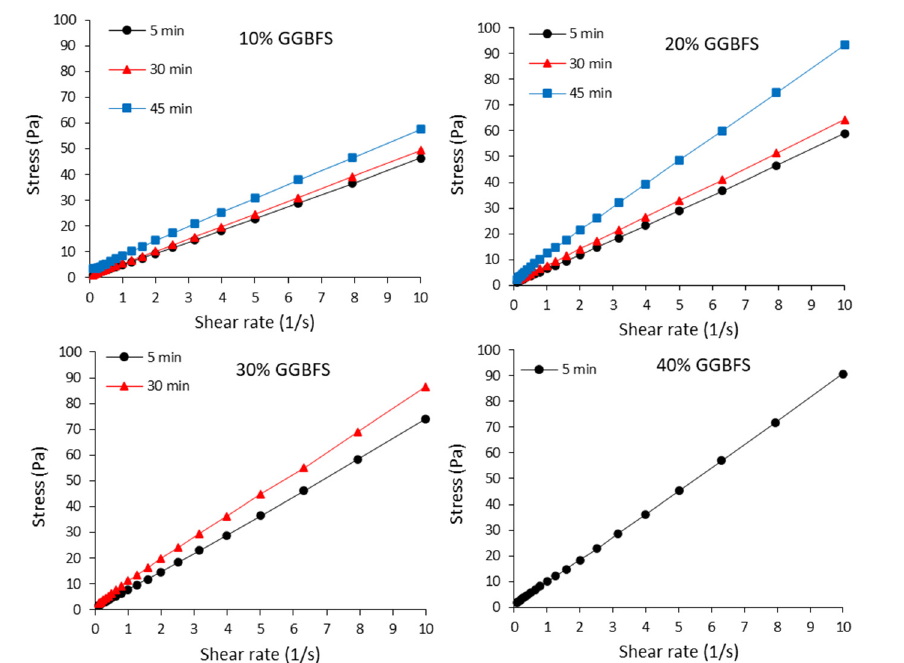
Figure 3. Flow sweep curve for pastes containing 10% ‐ 40% GGBFS.